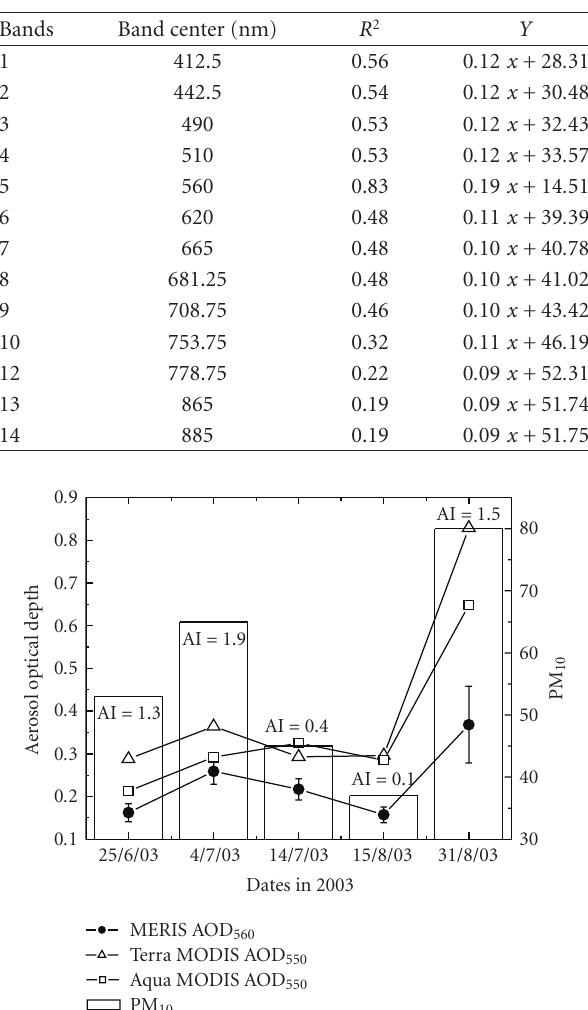
Figure 4: Mean daily values of AOD at 560 nm derived from MERIS at four sites with a 260 × 290m 2 spatial resolution and spatially averaged over the Athens Basin. The daily Terra/Aqua MODIS AOD 550 with 10 × 10 km 2 spatial resolution are also given. The PM 10 concentrations are four-station averaged value at the time interval corresponding to MERIS pass time. AI values for each day are given while the vertical bars express one standard deviation from the spatially averaged MERIS AOD value.